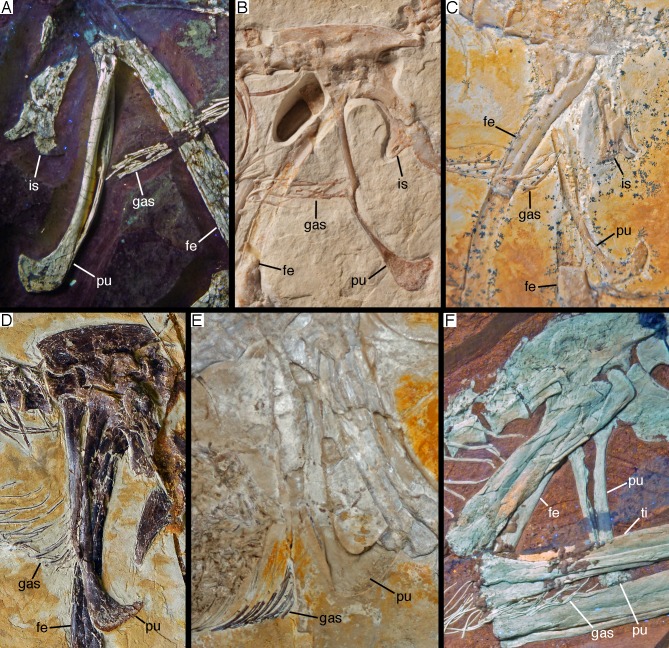
Position of gastralia in respect to the pubis in several theropods.(A) Twelfth specimen of Archaeopteryx, photograph under UV light. (B) Munich specimen of Archaeopteryx. (C) Eichstätt specimen of Archaeopteryx. (D) Anchiornis (STM0-52; photo courtesy of Wang Xiaoli). (E) Compsognathus (MNHN CNJ 79). (F) Sciurumimus (BMMS BK 11; photograph under UV light).